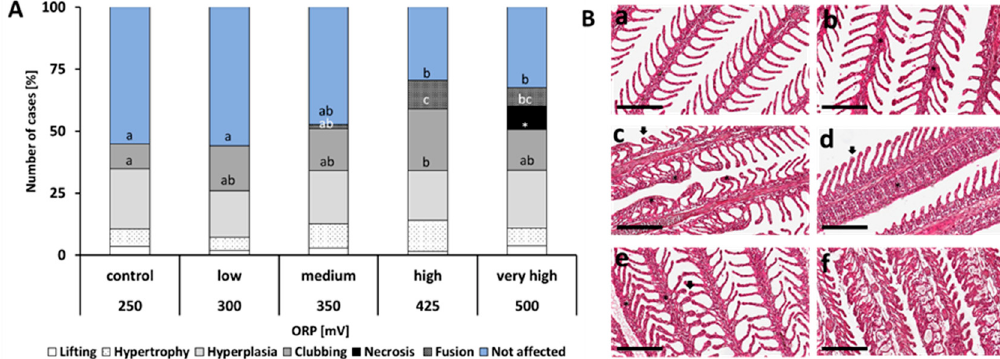
Figure 2. ( A ): Quantification of histopathological changes in the gills of Atlantic salmon exposed to 5 di ff erent ozone levels (250, 300, 350, 425 and 500 mV), expressed as oxidation reduction potential (ORP). Key histopathological parameters that were quantified include “not a ff ected”, “fusion”, “necrosis”, “clubbing”, “hyperplasia”, “hypertrophy” and “lifting” (modified from Reiser et al. 2011). Di ff erent letters denote statistically significant di ff erences ( p < 0.5). ( B ): ( a – f ) Representative photographs of some of the pathologies in the gills. ( a ) Healthy gill lamellae with well-defined structures; ( b ) hyperplasia (*) at the base of a lamella; ( c ) di ff erent degrees of partial fusion (*) of the gill filaments and signs of lamellar clubbing ( ↓ ); ( d ) complete fusion of several lamellae (*) and early sign of epithelial lifting( ↓ ); ( e ) signs of hyperplasic and hypertrophy (*) and clubbing and shortening of the lamella ( ↓ ); early stage of lamellar fusion from the base can be observed as well; ( f ) loss of brachial structure, heavy degeneration and evidence of necrotic tissues. Scale bar ( ― ) = 200 µm.